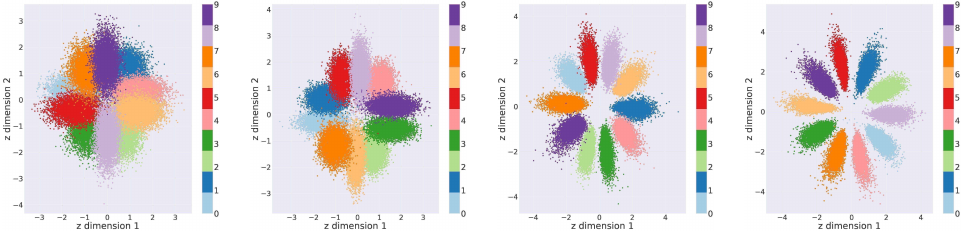
Figure A1. 2-D MNIST latent space visualization with different β values. From left to right, visualiza- tion of β =